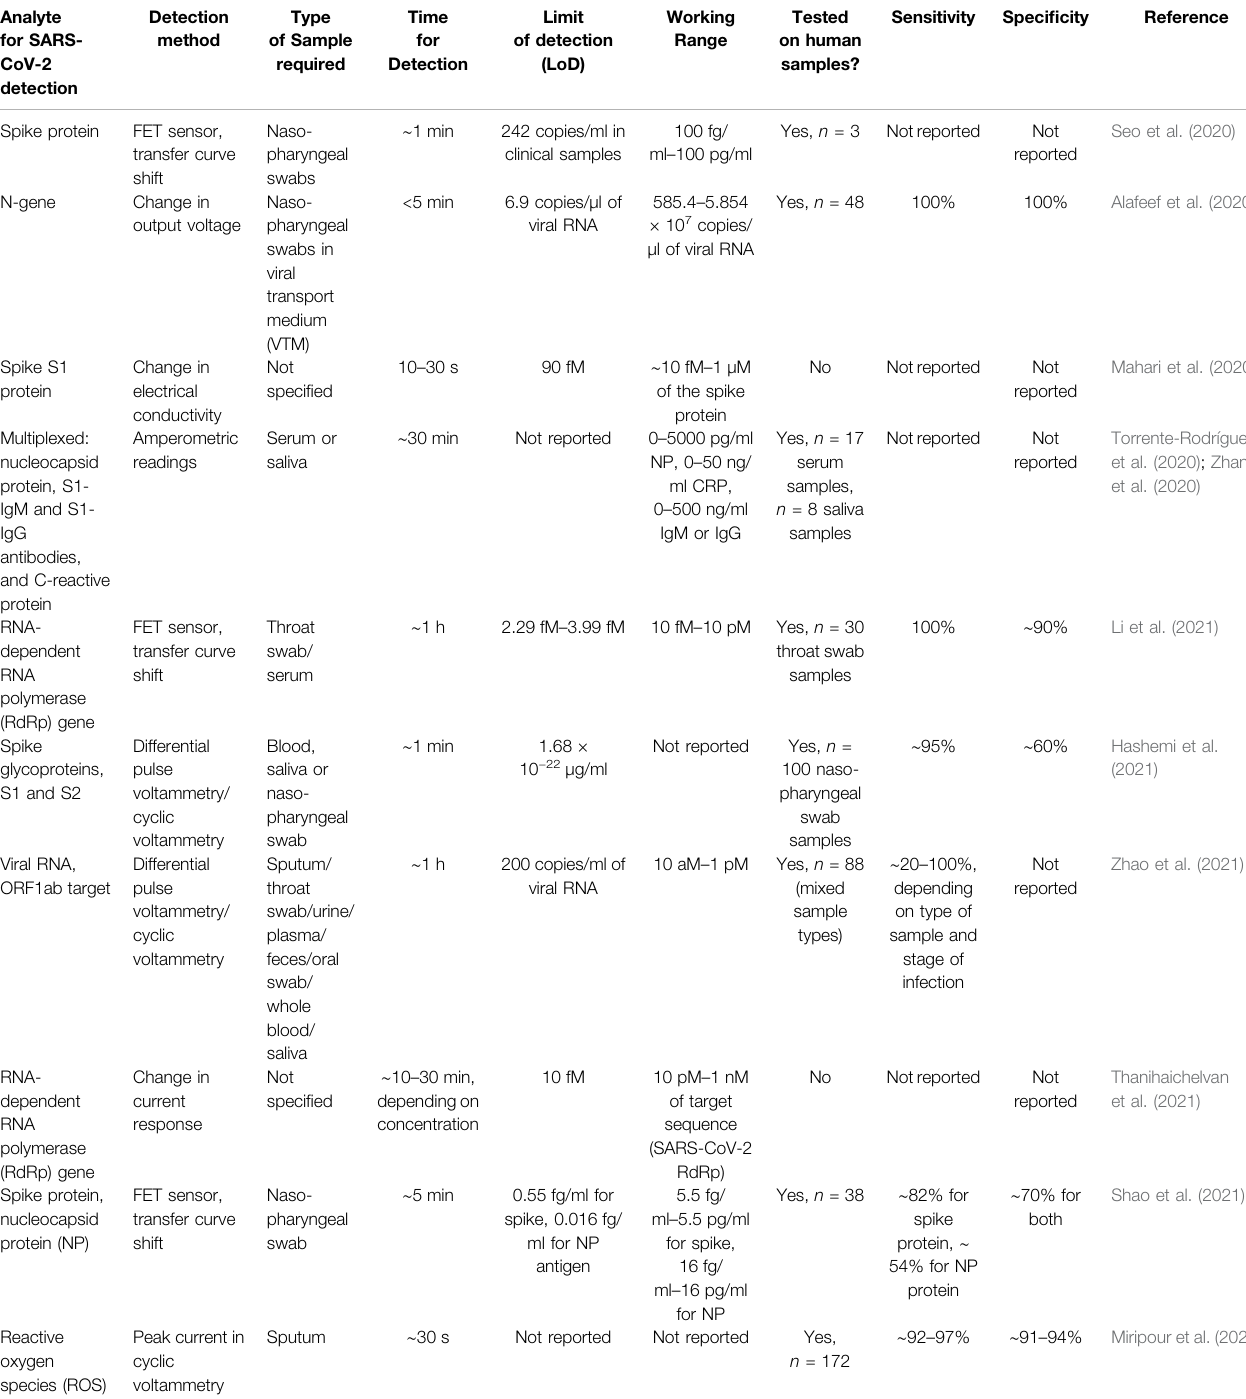
TABLE 3 | Summary of reported methods for detecting SARS-CoV-2 using electrochemical biosensors based on carbon nanomaterials. Analyte for